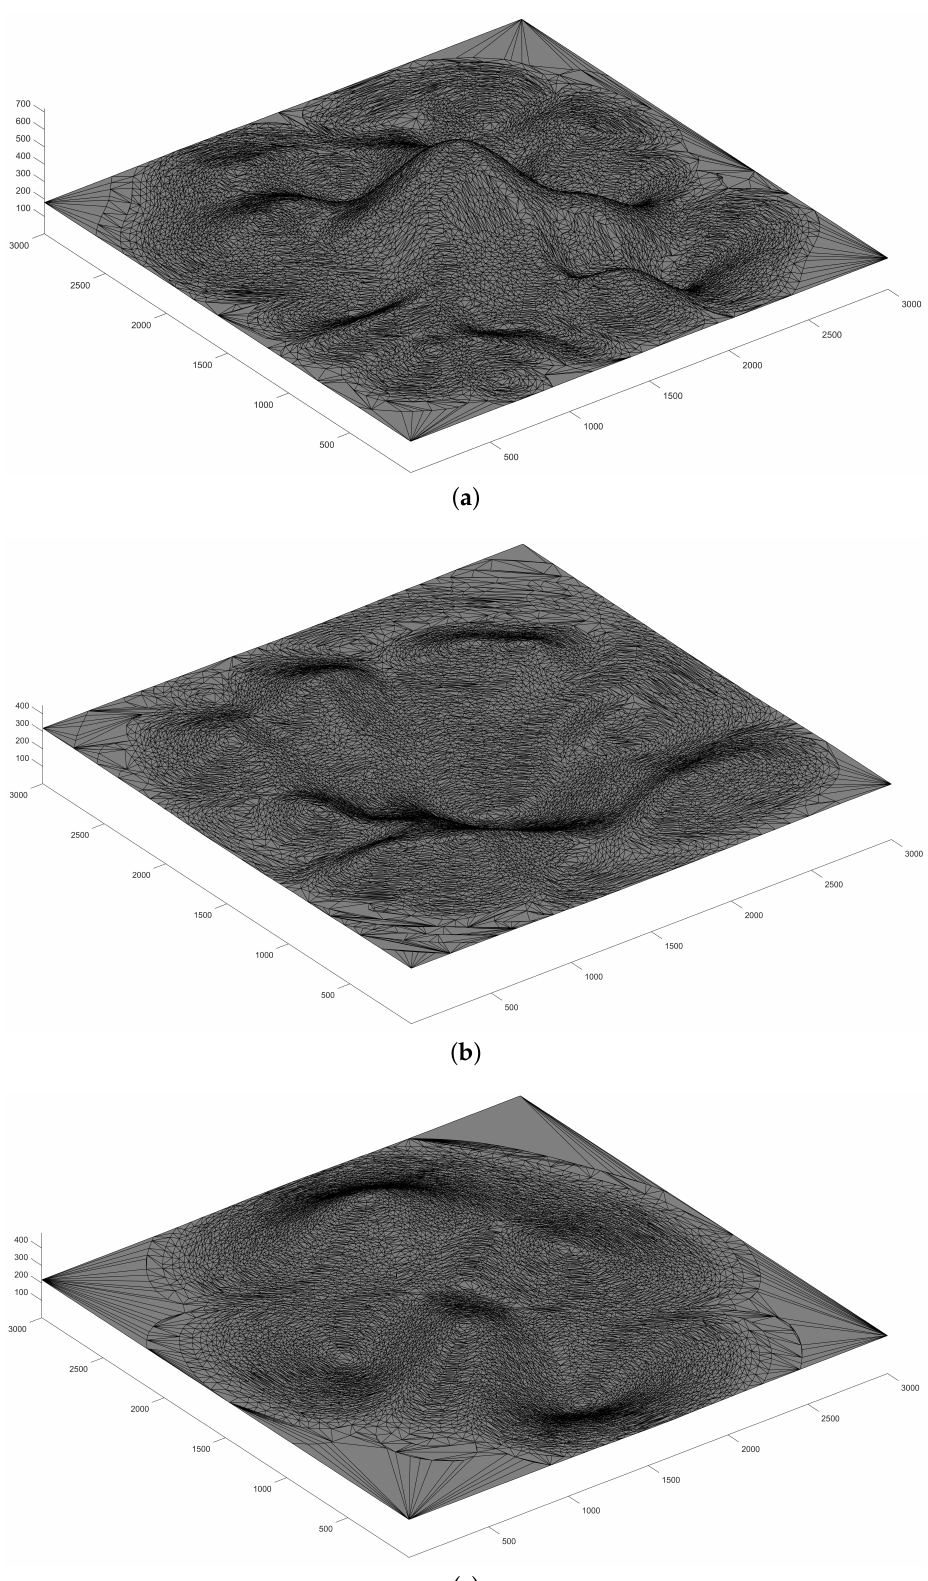
Figure 4. The three different terrains used in our simulations: ( a ) the mountain topography; ( b ) the valley topography and ( c ) the complex